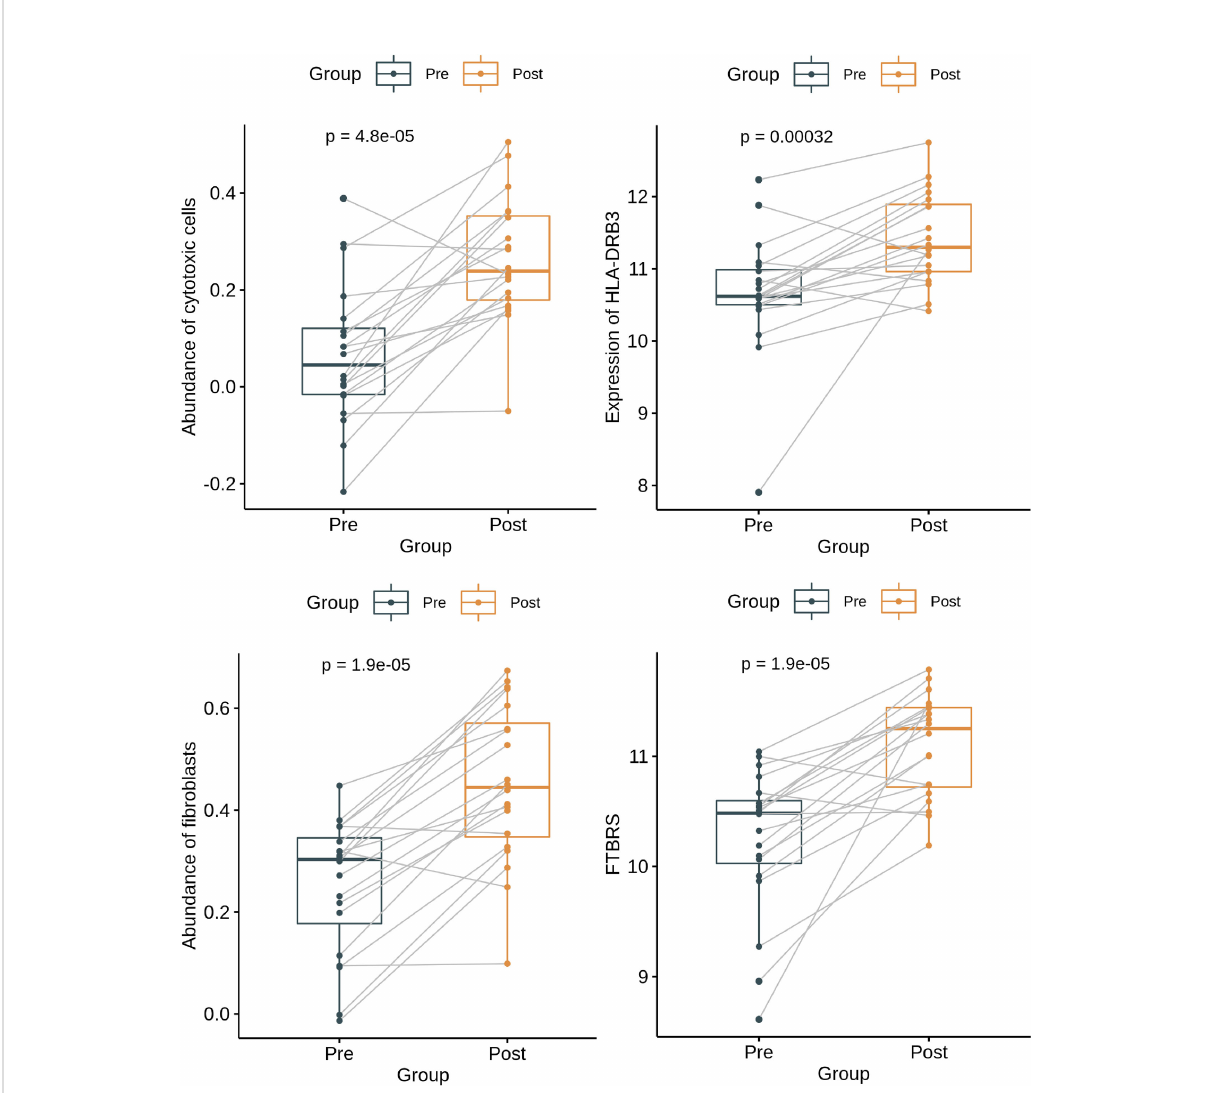
FIGURE 4 Paired box plots showing changes in abundance of cytotoxic cells, expression level of HLA-DRB3, abundance of fi broblast cells, and FTBRS between after nCRT and before nCRT.